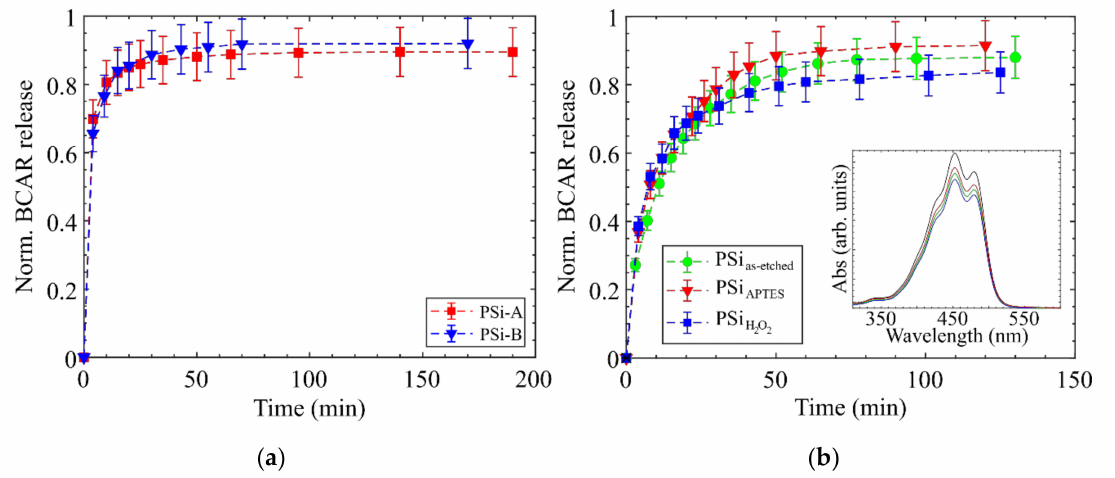
Figure 6. ( a ) Comparison between the two type of PSi structure investigated. Normalized BCAR release from (red squares) PSi-A and (blu triangles) PSi-B. ( b ) BCAR releases from PSi with di ff erent surface functionalization: (green circles) as-etched PSi-A; (red triangles) PSi-A functionalized with APTES; (blu squares) PSi-A treated with hydrogen peroxide. The inset shows the absorption spectra of BCAR, showing no lineshape modifications between the load and releases experiments (black curve reference of a BCAR solution). The di ff erent profiles between panel ( a ) and ( b ) are due to the di ff erent thickness of the two set of samples (23 µ m in Figure 6a vs. 46 µ m in Figure 6b). See Figure 7 for more details. All samples were loaded with 20 µ L of 0.3 mg / mL BCAR solution, as this is the concentration at which a decrease in the amount of BCAR released starts (see Figure 4a2 blue